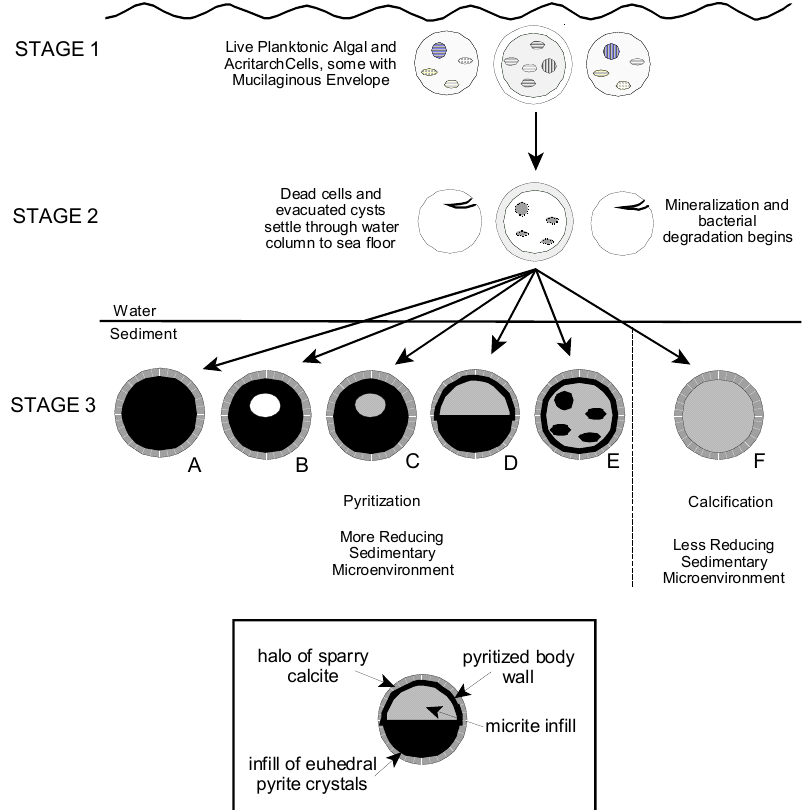
Figure 14. Taphonomy of the Tully microflora. Model for the mineralization of algal and acritarch cells preserved in the Lower Tully Limestone at Lock Haven, PA. Arrows indicate passage between preservational stages. They do not indicate that only dead cells rather than cysts give rise to mineralized material in Stage 3. ( STAGE 1 ) Live planktonic algal and acritarch cells, some with a mucilaginous envelope, dispersed in the oxygenated surface waters of the Appalachian Seaway; ( STAGE 2 ) Settling through the water column of empty cysts and dead cells, and incorporation into the substrate; ( STAGE 3 ) Mineralization within the sediment. Formation of halo of sparry calcite crystals, micrite and pyrite infills A – F : different end members of Tully mineralization processes: ( A ) specimen completely pyritized and filled with pyrite; ( B ) pyritized specimen with a hollow interior space; ( C ) pyritized specimen filled primarily with pyrite and a small micrite mass. ( D ) Specimen with pyritized wall and pyrite-micrite infill; ( E ) Specimen with pyritized wall and micrite infill interspersed with globular pyrite clusters; ( F ) Specimen with little or no pyritization and filled entirely with micrite.